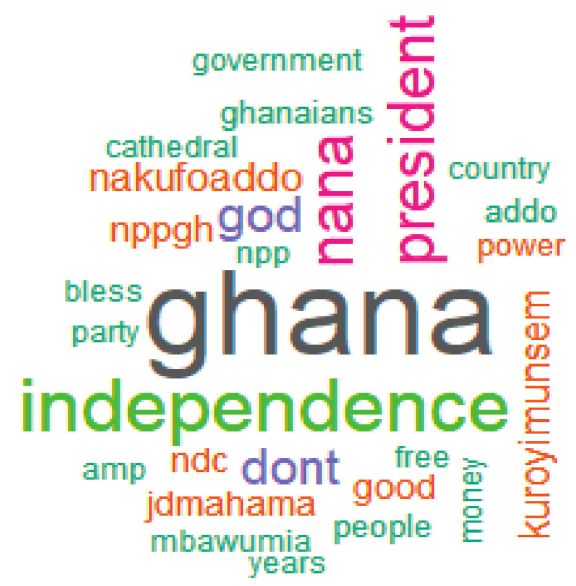
Figure 1: Word cloud of tweets.